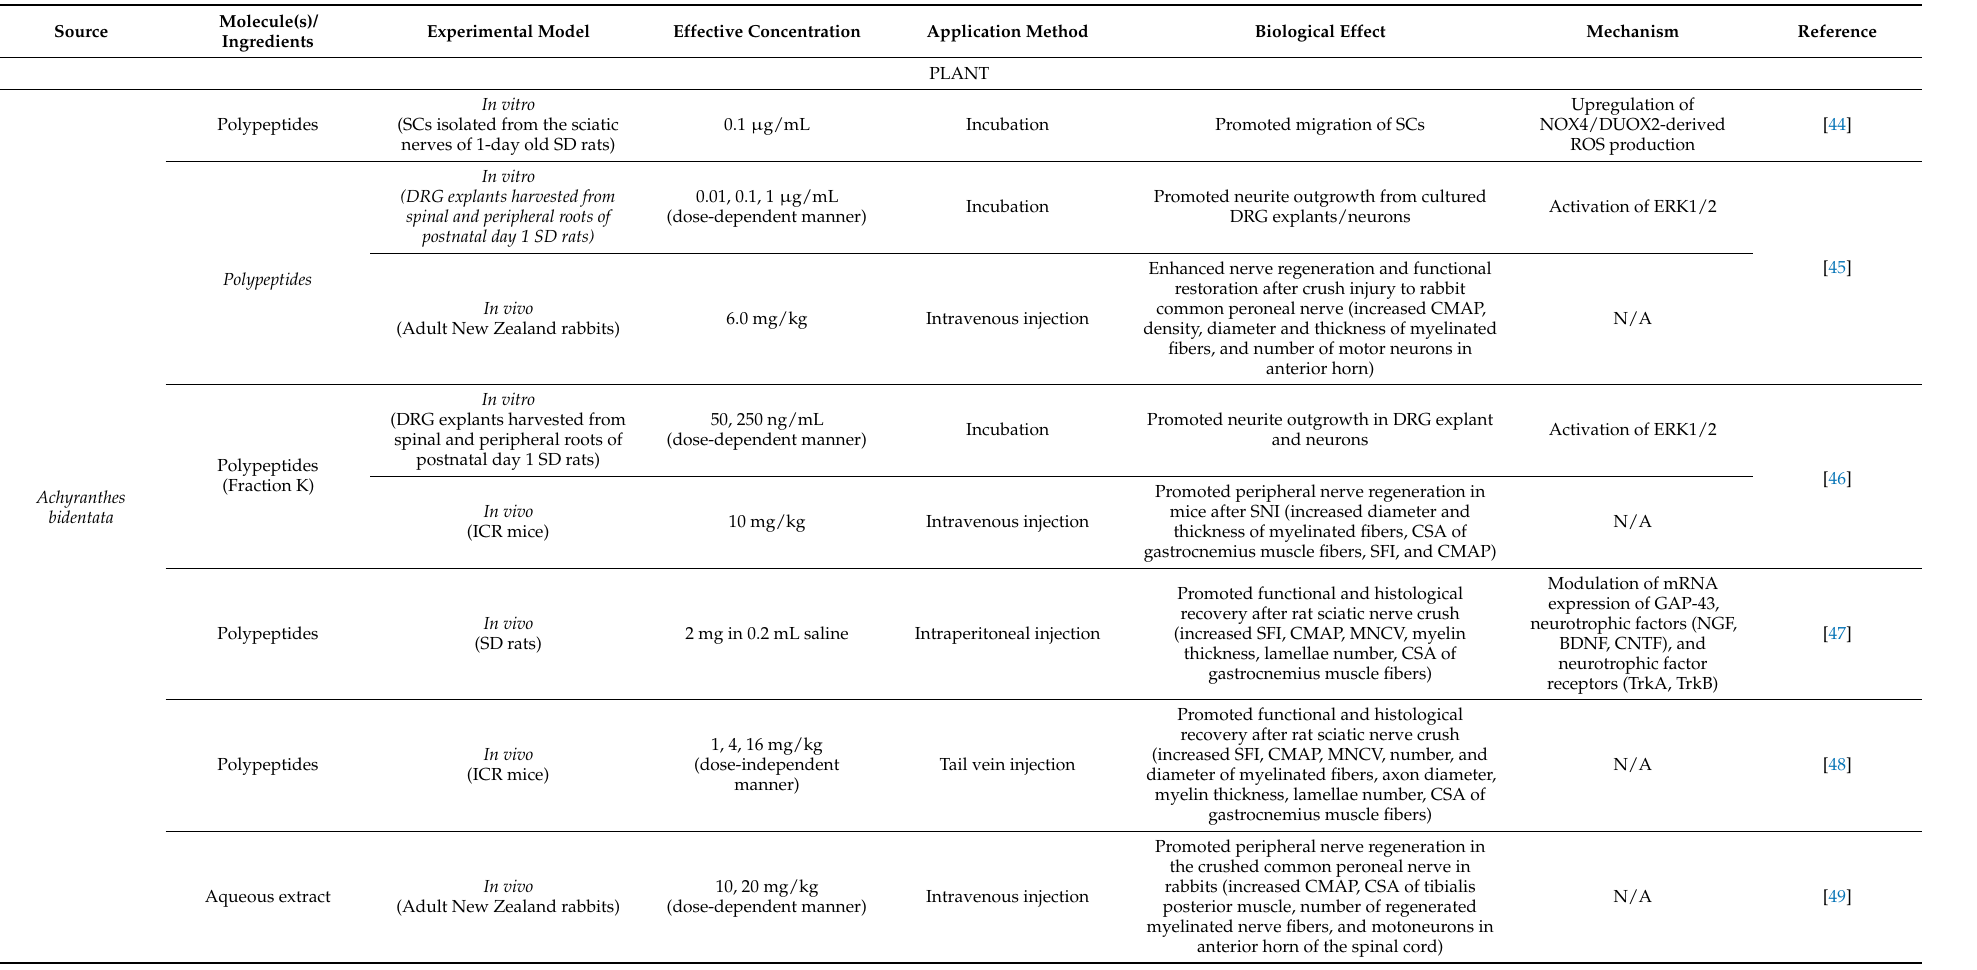
Table 1. Summary of plants, mushrooms, and decoctions their natural products relating to peripheral nerve